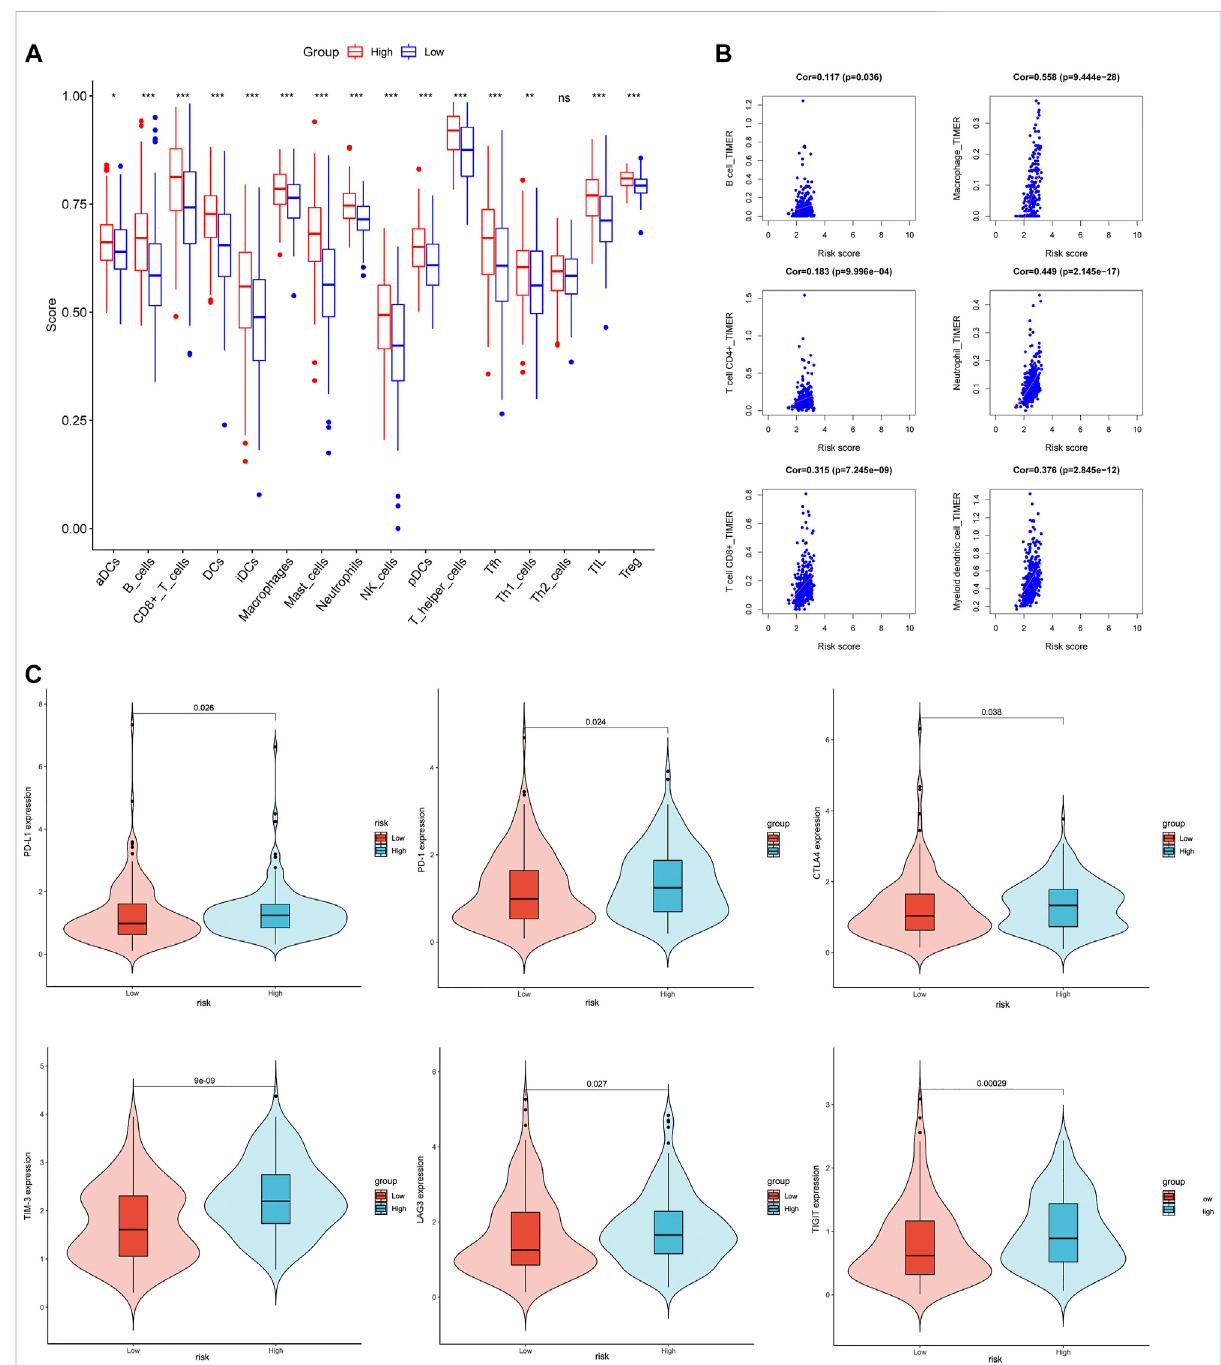
FIGURE 7 Correlation between Coag-Score and tumor immune in fi ltrating cells and immune checkpoints. (A) The ssGSEA scores between the high-risk and low-risk groups in the TCGA cohort. (B) Correlation between Coag-Score and immune in fi ltrating cells in the TIMER database. (C) Levels of immune checkpoint gene expression in high-risk and low-risk groups in the TCGA